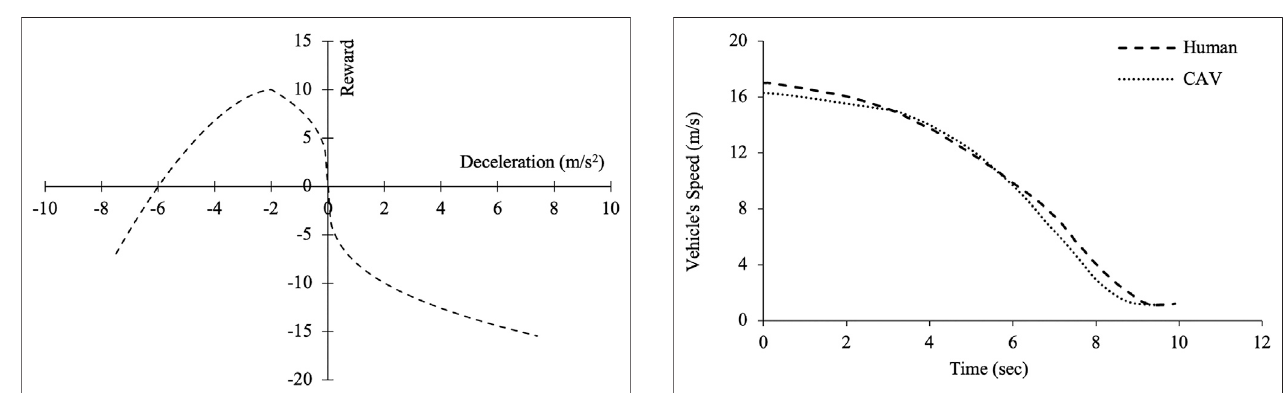
’ andtheproposedCAVbrakingpro fi lesunderfree- fl ow driving